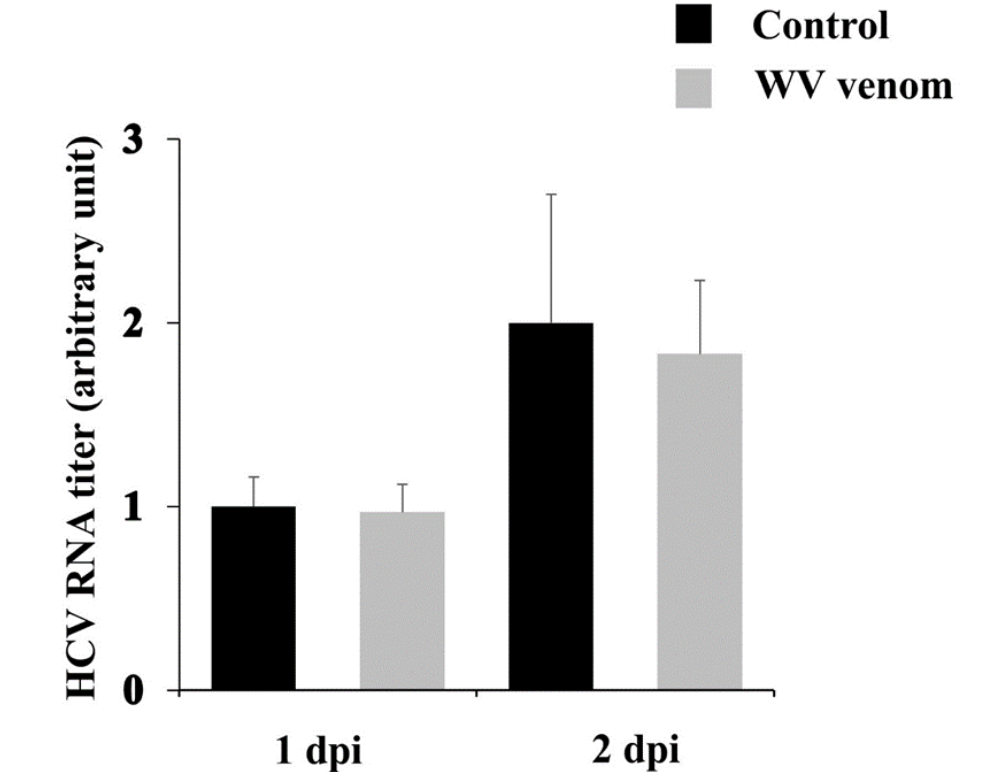
Figure 4. WV post-infection treatment does not affect HCV RNA levels in the infected cells. Huh7it-1 cells were infected with HCV and then treated with the venom (500 ng/mL). At 1 and 2 dpi, HCV RNA was quantified by using qRT-PCR and normalized to GAPDH mRNA expression.